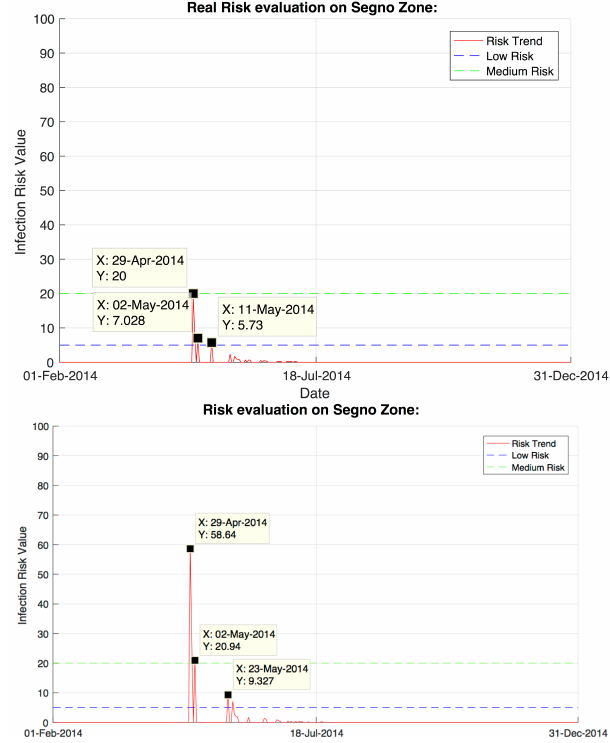
Figure 8. Risk evaluation comparison; on the top, the risk evaluation for Segno’s zone using weather data of its own weather station; at the bottom, the risk evaluation for Segno’s zone using leaf wetness evaluated with the MLP.